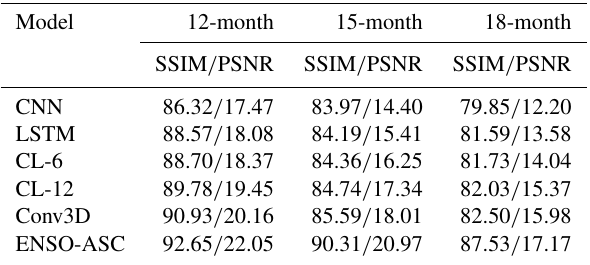
Table 2. Performance comparisons with other state-of-the-art deep learning